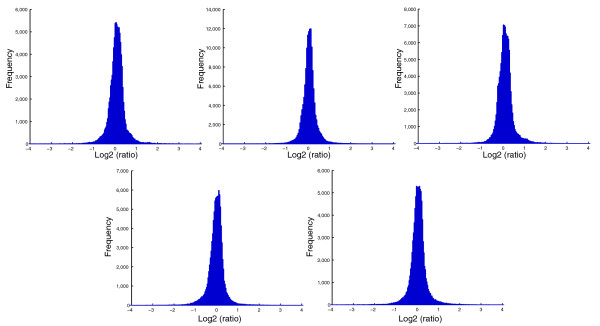
Distribution of ratios for quantified peptides for the five IPAS experiments. A histogram of 1-year CEE/baseline (log2) ratios as determined from heavy-to-light isotopic labeling with acrylamide are shown for each IPAS experiment. The median of the distribution was centered at zero for normalization.